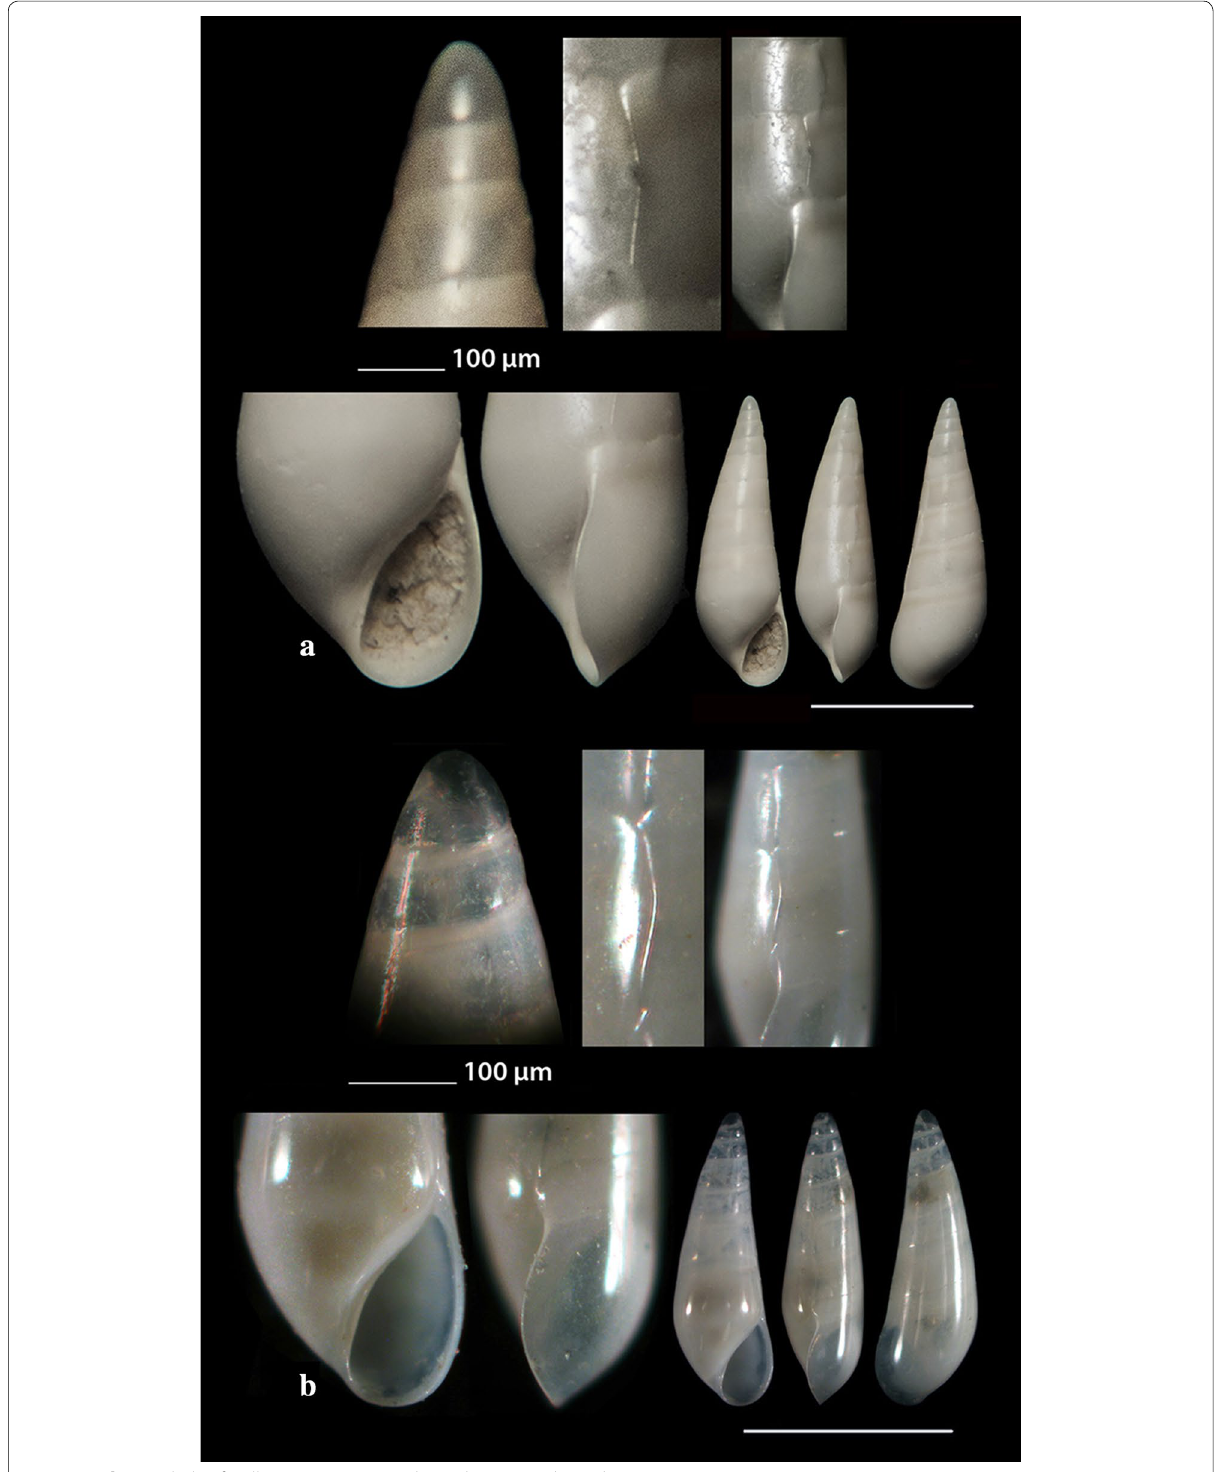
Fig. 18 a , b Acrochalix cf. callosa . Bar